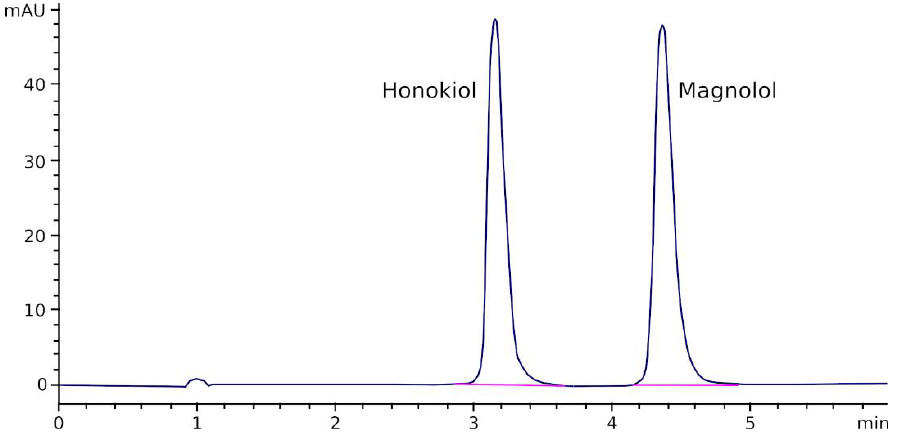
Figure 2. Chromatogram obtained after the injection of a mixture containing magnolol and honokiol (10 µ g/mL each) into the HPLC equipment. A linear relationship was found between the magnolol and honokiol peak area and their concentrations in standards in the range of 0.1–100 µ g/mL (magnolol: Peak area = 41.74 × Conc( µ g/mL)—12.31; honokiol: Peak area = 69.97 × Conc( µ g/mL)—7.43; r > 0.9992 for both relationships). LOD was approximately 0.01 µ g/mL, and LLOQ